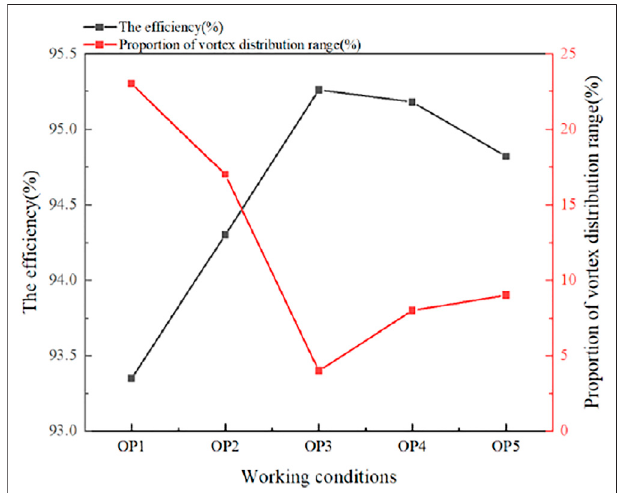
FIGURE 9 | Relationship between the vortex distribution range and ef fi